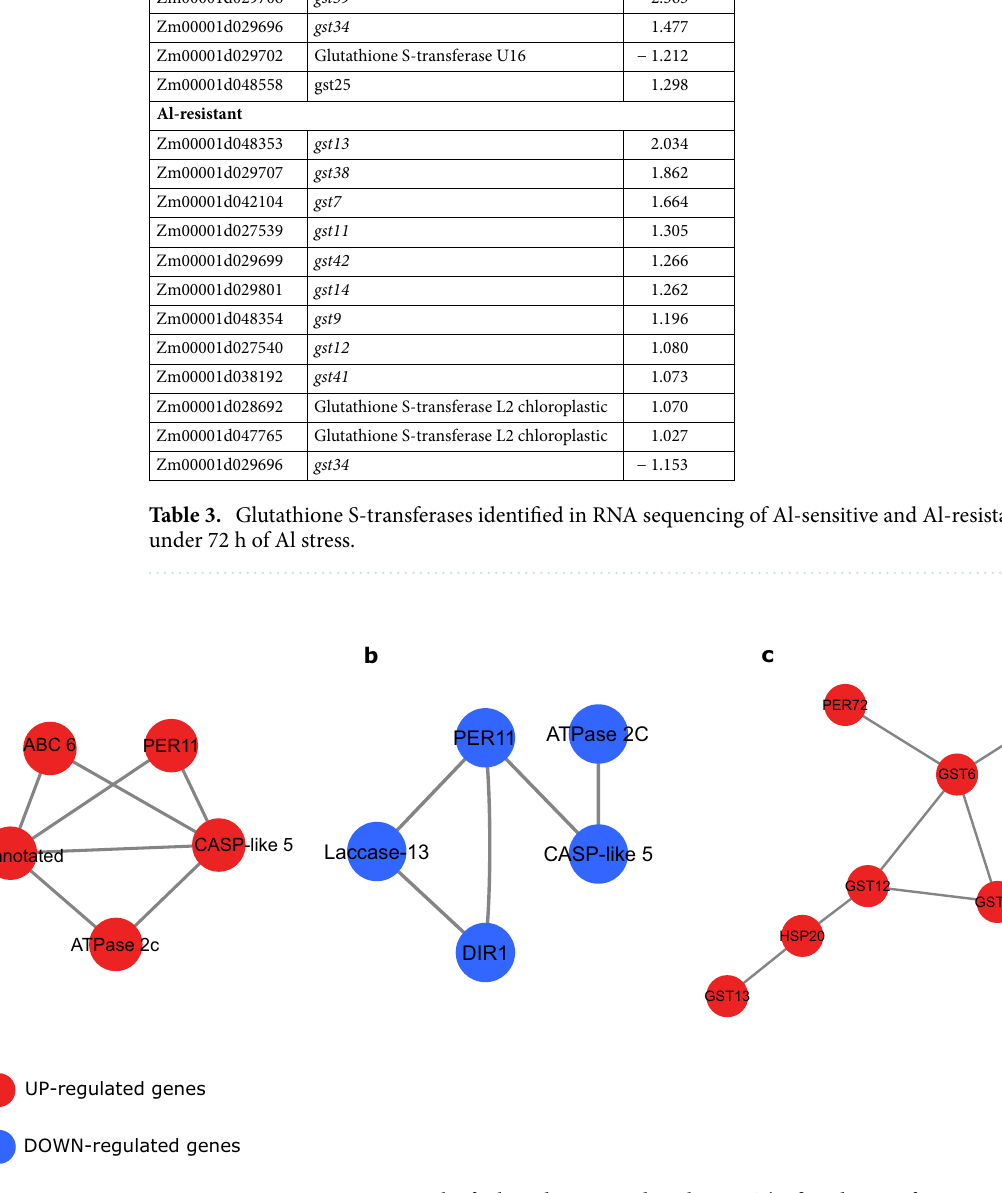
Figure 4. Co-expression network of selected DEGs under Al stress. The first degree of interaction was retrieved from STRING (version 10.5) using a minimum required interaction score of 0.7, and the network analysis performed in Cytoscape (version